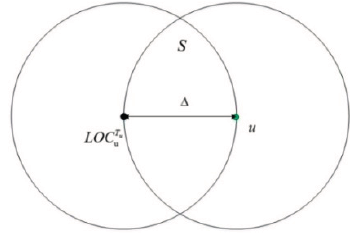
Figure 6. An example of updating the location-based keys in an extreme